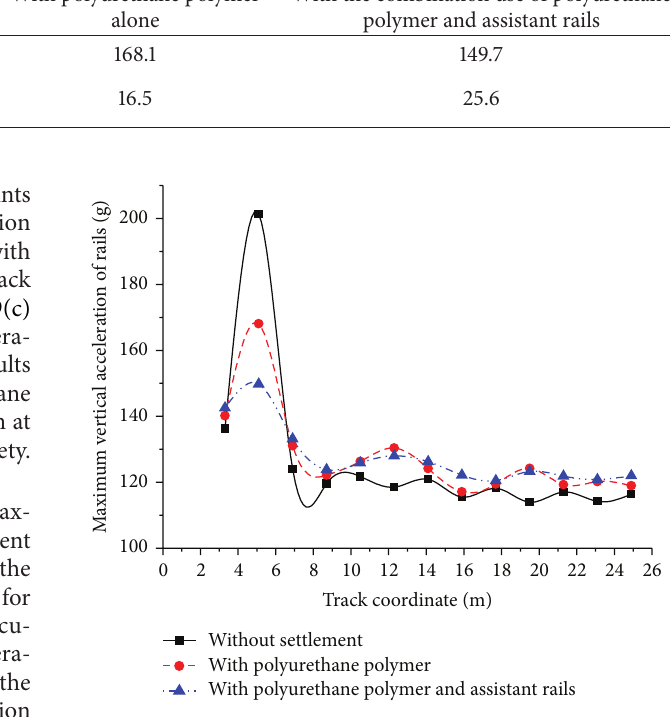
Figure 10: The maximum vertical accelerations of the rail at each measuring